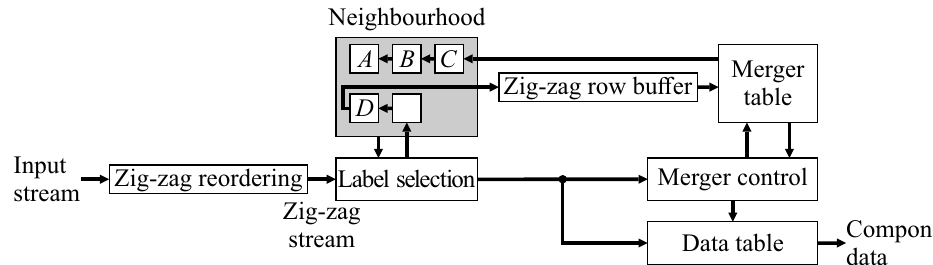
Figure 3. Basic architecture of zig-zag based single-pass connected components